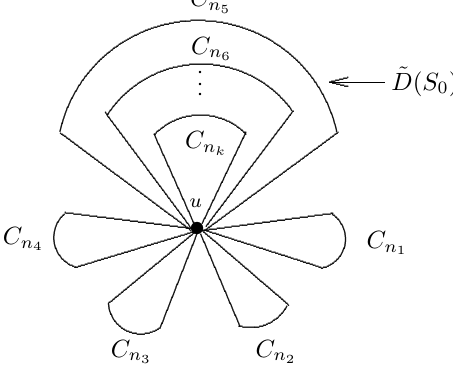
Figure 9: A planar embedding ˜ D ( S ) of D ( S ) in Case